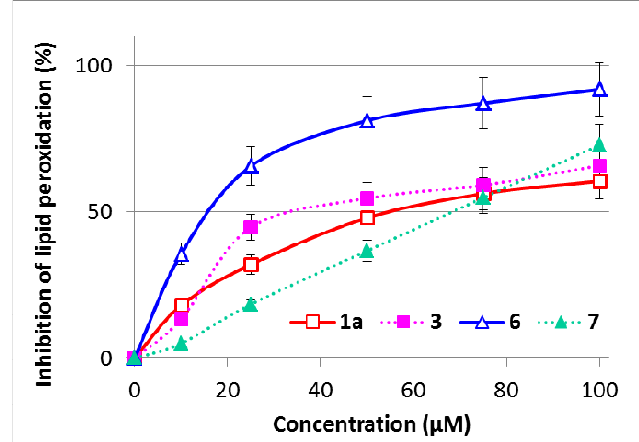
Figure 3. Effect of silybin and 2,3-dehydrosilybin dimers on inhibition of lipid peroxidation induced by 1 mM tert -butyl hydroperoxide in rat liver microsomes. The concentration of lipid peroxidation products was determined as thiobarbituric acid reactive substances (TBARS) and presented as %. Data are means ± SD from three independent experiments performed in